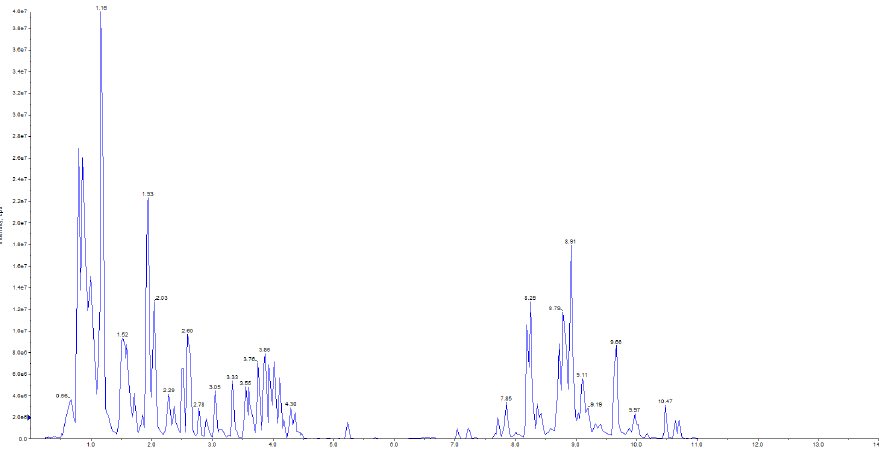
Figure 1. Analysis of the total ion current (TIC) in di ff erent quality control (QC) samples. The abscissa represents the retention time (min) of metabolite detection, and the ordinate represents the intensity (cps: count per second) of the ion